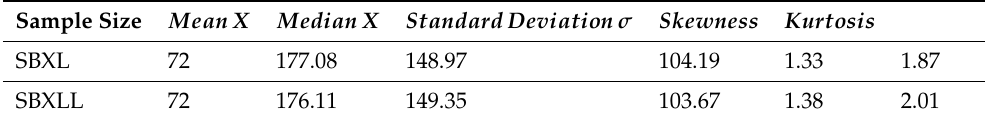
Table 26. Theoretical statistical measures of SBXL and SBXLL from data-V.